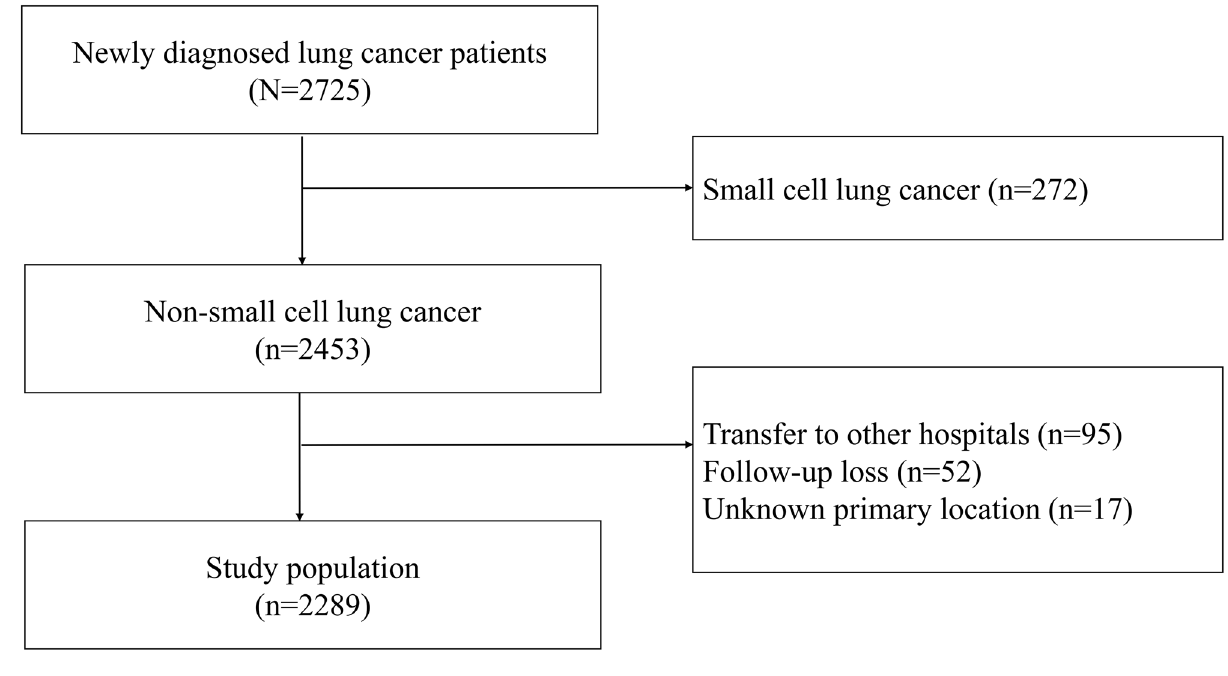
Figure 1. Flow diagram of study